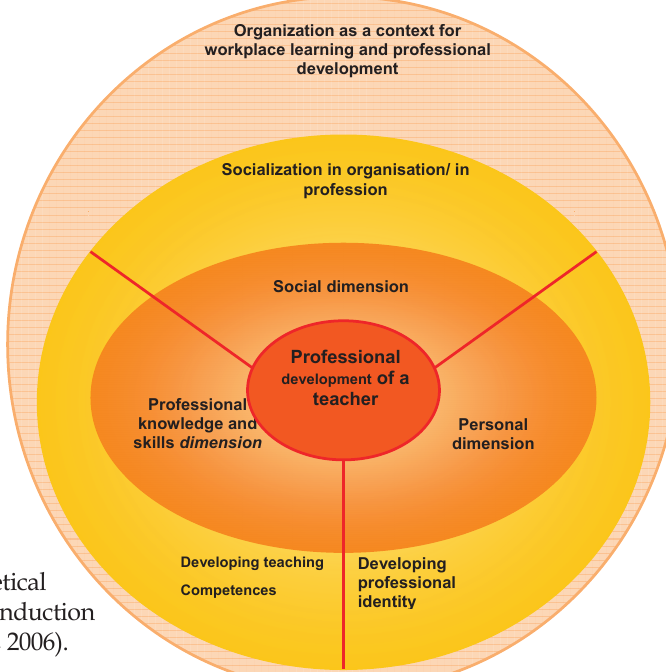
Figure 3. Theoretical foundations of the induction year (Eisenschmidt,